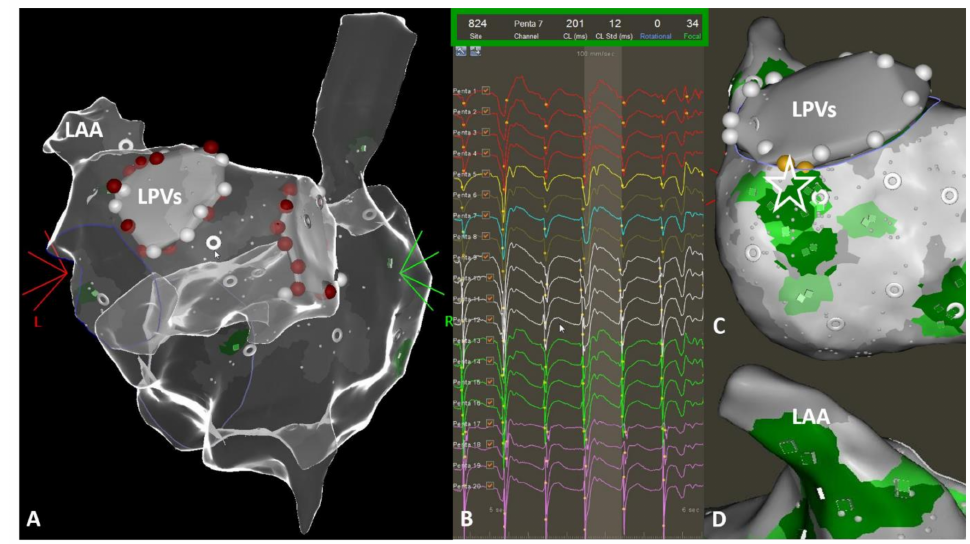
Figure 4. ( A , C ) Typical example for focal activities (green color) revealed from CARTOFINDER mapping of the right and left atrium and left atrial appendage. ( D ) The grey ring represents the center of a mapping position, using the PentaRay catheter. The light grey surface around the ring visualizes the coverage of the LA wall surface with the five PentaRay splines. ( B ) Focal activation is detected by identifying an S wave in the unipolar electrograms. If S wave patterns preceding activity on neighboring electrodes are detected during at least two consecutive atrial cycles, the site is designated as a focal source.